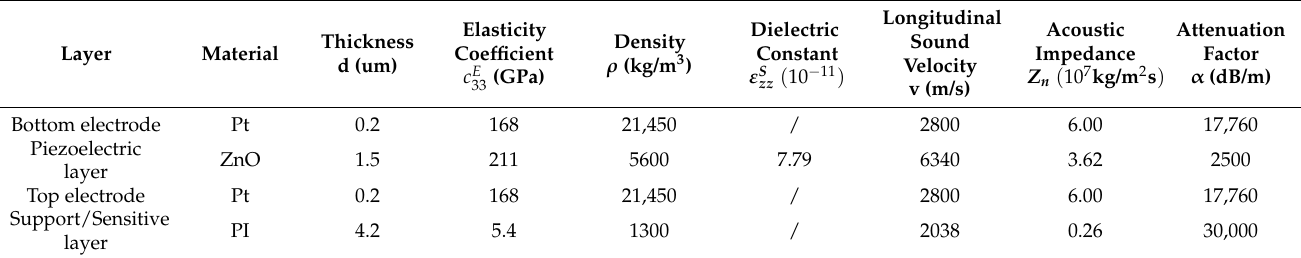
Table 1. The thickness and material parameters of each layer in the PI-FBAR multilayer film equiva- lent transmission line model.